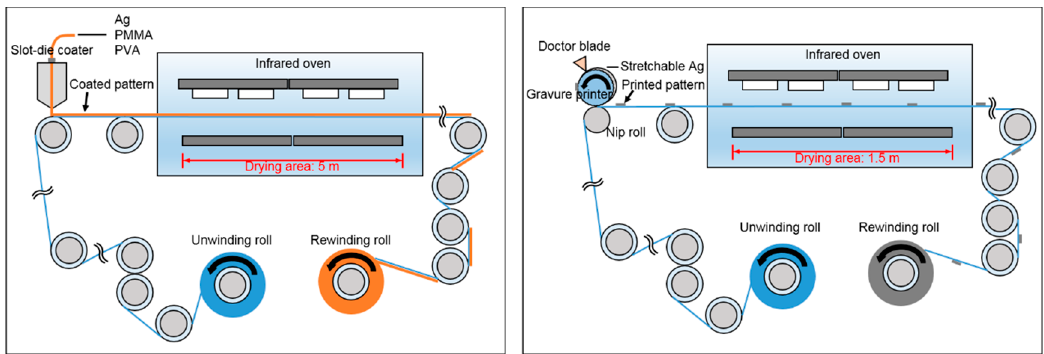
Figure 1. Schematics of the roll-to-roll slot-die coater ( left ) and gravure printer ( right ).